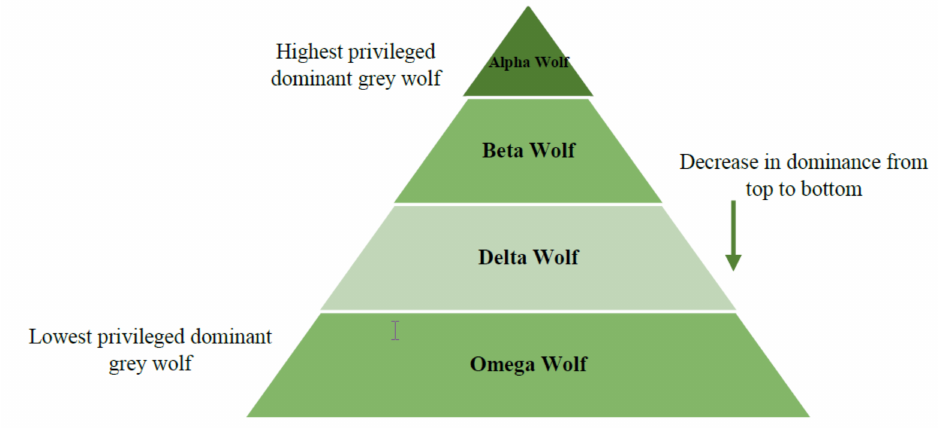
Figure 1. The dominance hierarchy of grey